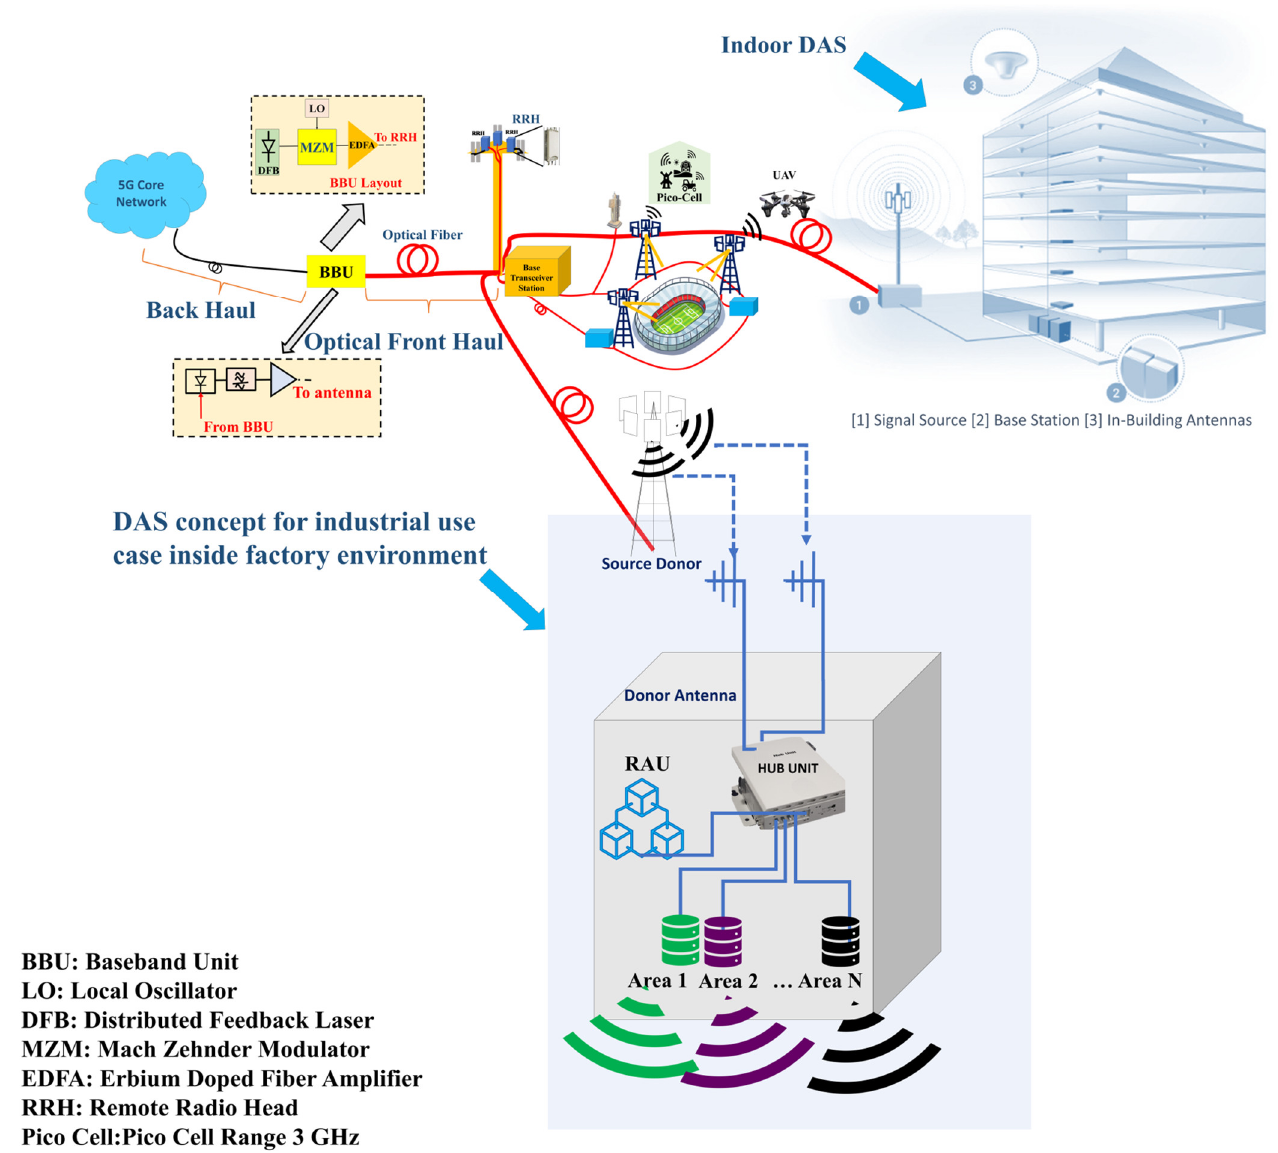
Figure 1. Block diagram showing a backhaul, the baseband unit (BBU) connected to an optical front haul (OFH). The base station connects the remote radio heads (RRHs), the distributed antenna system for industrial and indoor factory use case is also shown where RoF as an OFH is connected to the RRH and then DAS via source donor and receive antennas is integrated with hub unit for wireless connectivity.